Question: Summarize what this figure shows in one sentence.
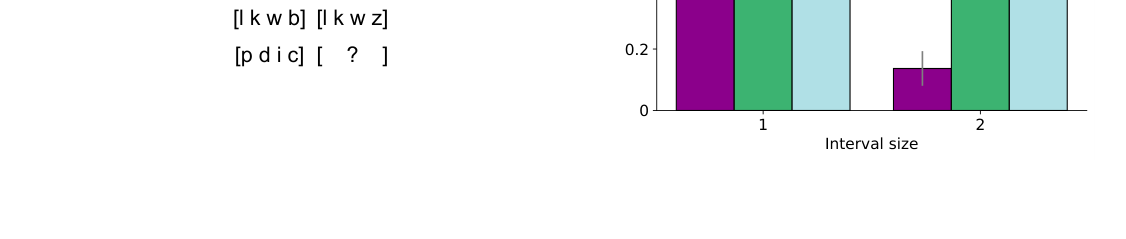
Answer: Results for letter-string analogies with shuffled alphabet. (a) Example problem from Hodel & West [2]. Letter-string analogies are constructed based on a permuted alphabet. This example involves a successor relation with an interval size of 1, applied to the final letter of the string. Other problems involved an interval size of 2. See Methods (Supplementary Section S1) for more details. (b) Results for human participants, GPT-4, and a variant of GPT-4 augmented with the capacity to write and execute code (which the model used to identify the positions of letters in the permuted alphabet). Both humans and GPT- 4 showed greater difficulty on problems involving an interval of size 2 (main effect of interval size, human participants: P = 1.5 × 10−11, GPT-4: P < 2 × 10−16). This effect did not reach significance for GPT-4 + code execution (P = 0.066). Human participants outperformed GPT-4 (main effect of human participants vs. GPT-4: P = 8.9 × 10−13), but GPT-4 + code execution p